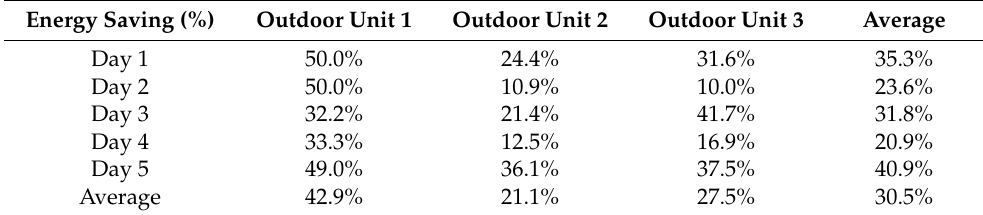
Table 4. Daily and average energy